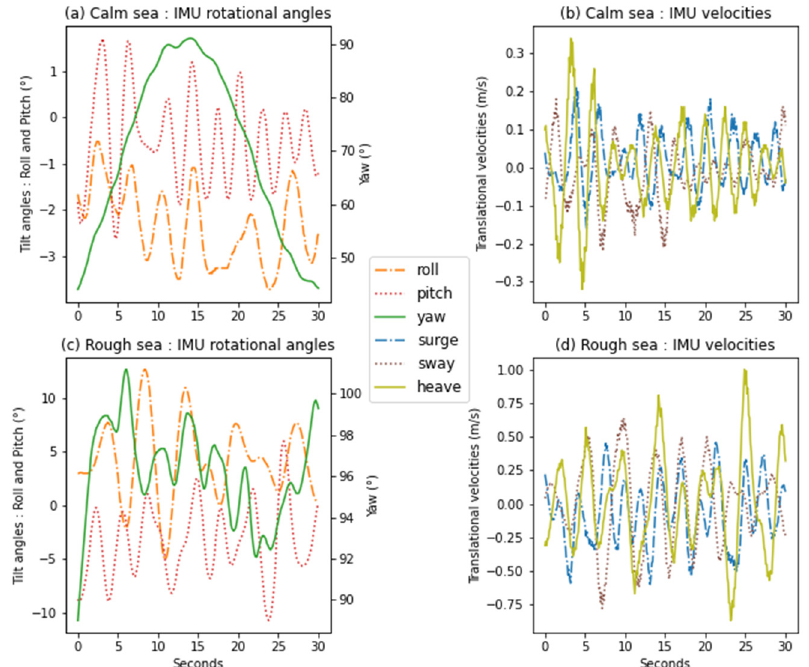
Figure 3. Measurements of the six degrees of freedom from the IMU on board of the WINDSEA_02 buoy. Rotational angles are presented for calm; and ( a ) rough; ( c ) sea conditions. Translational velocities are presented for calm; and ( b ) rough; ( d ) sea conditions.